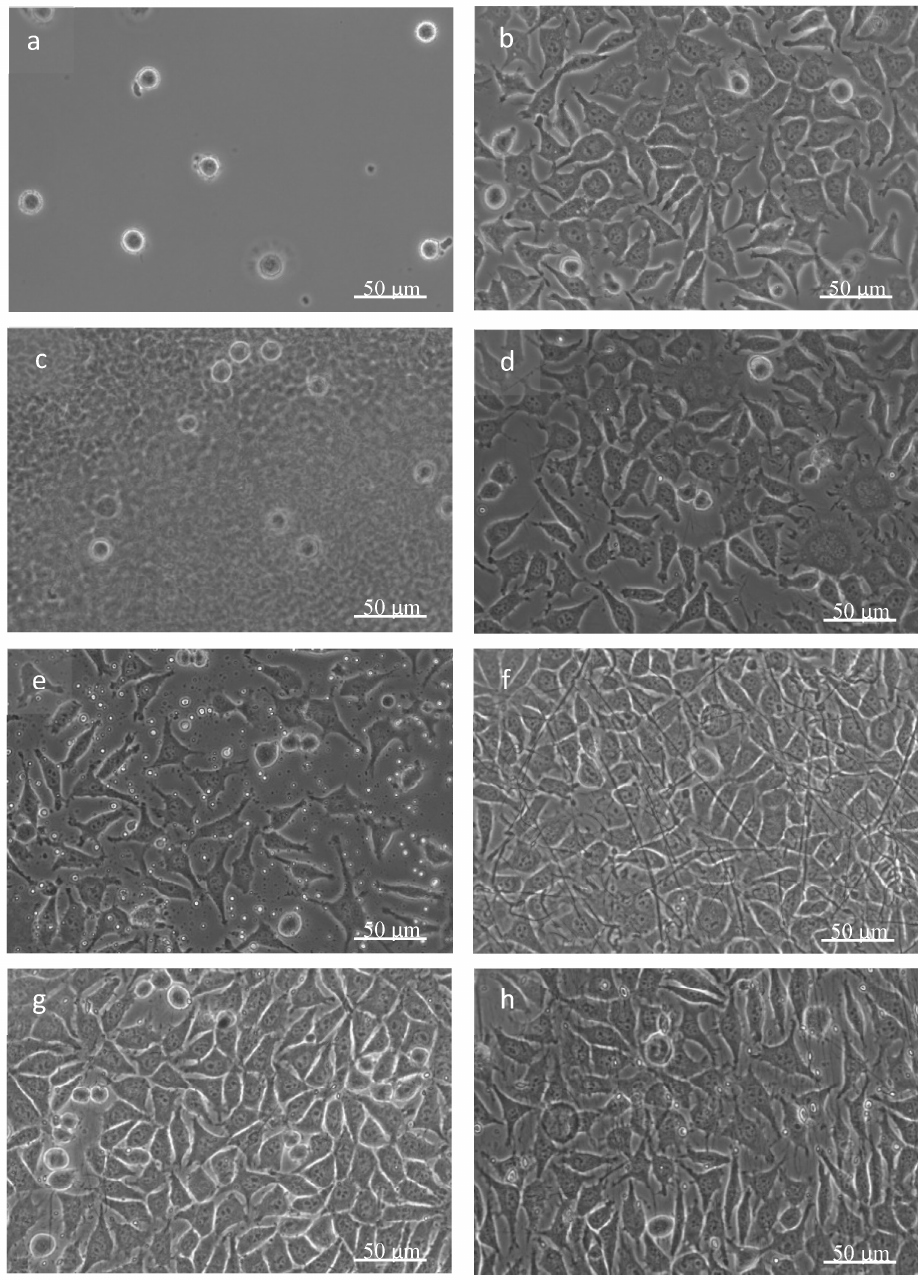
Figure 8. Photo of the cultivated cells on a sample surface, sample ( a,b ) 0 after 30 min and 72 h respectively, ( c ) PCL-1, ( d ) PCL-2, ( e ) PCL/HA-1, ( f ) PCL/HA-2, ( g ) PCL/HA-3, and ( h ) PCL/HA-5, all after 72 h.